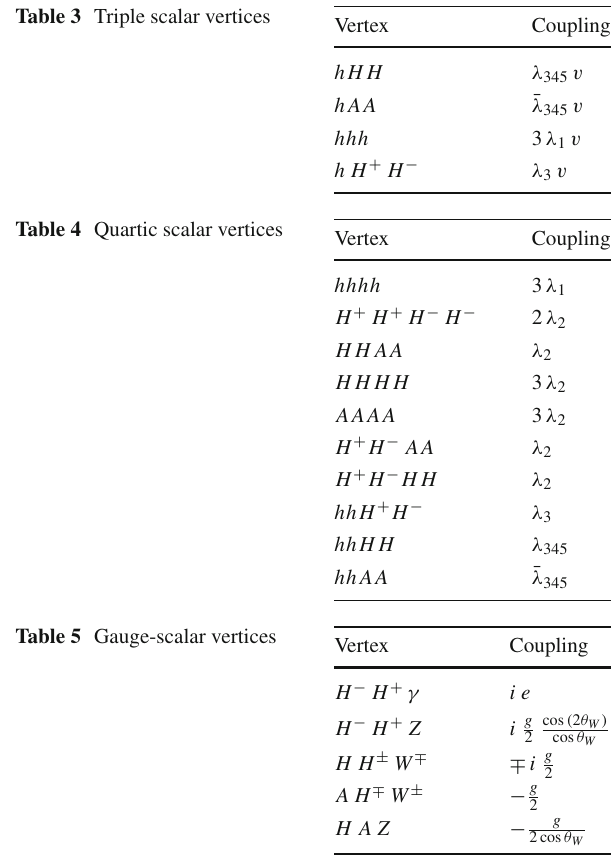
Table 5 Gauge-scalar